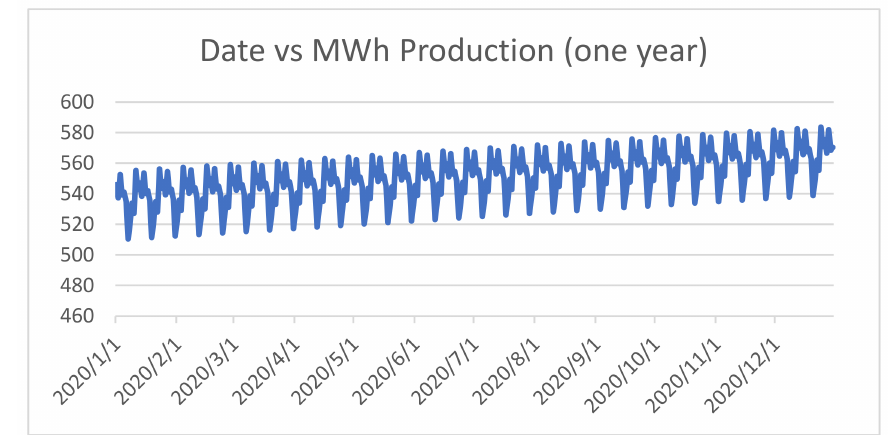
Figure 7. One-year prediction results of MWh from 1 January 2020 to 1 December 2020.